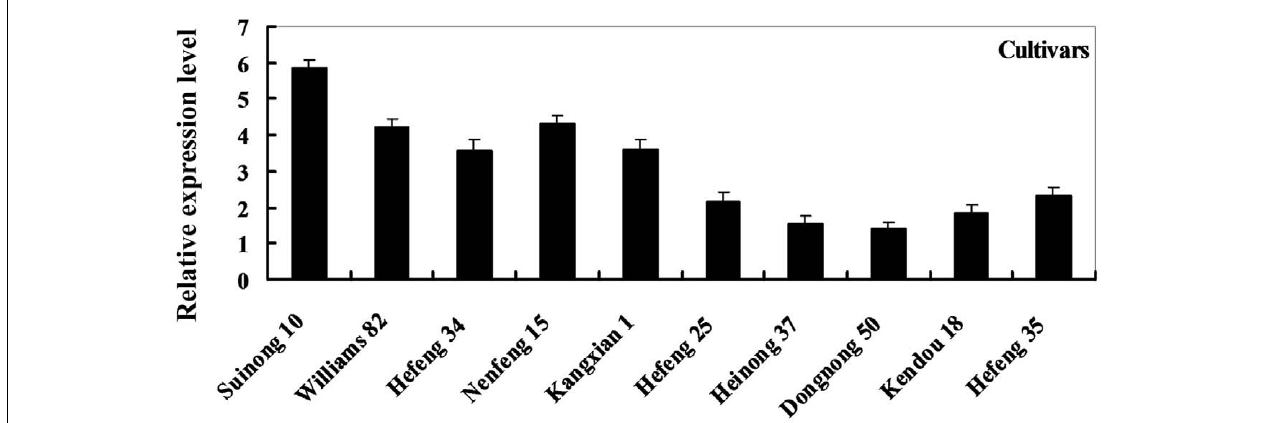
FIGURE 2 | Relative expression levels of GmDIR22 in resistant and susceptible soybean cultivars, at 48 h after P. sojae infection. The soybean cultivars ‘Suinong 10,’ ‘Williams 82,’ ‘Hefeng 34,’ ‘Nenfeng 15,’ and ‘Kangxian 1,’ which were resistant to P. sojae race 1. The soybean cultivars ‘Hefeng 25,’ ‘Heinong 37,’ ‘Dongnong 50,’ ‘Kendou 18,’ and ‘Hefeng 35’ which were susceptible to P. sojae race 1. Experiments were performed using three biological replicates with three technical replicates each. Bars indicated standard errors of the mean.